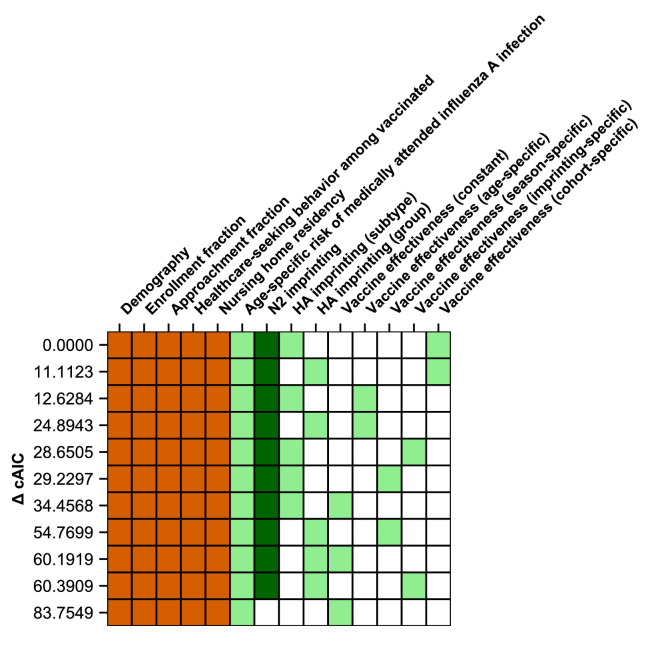
Ranking of models fitted to people ≥15 years old.A model including age-specific risk of medically attended influenza A infection, HA subtype imprinting, and birth-cohort-specific VE best fits cases of people ≥15 years old. The 11 main models are shown as rows with colored squares indicating whether that model uses parameters indicated by the columns. Orange squares indicate covariates that were not estimated. Light green squares mean that a given estimated parameter was supported. Dark green squares mean that the model did not support the inclusion of the parameters indicated by the column (i.e, the CI includes 0). Models are sorted by their cAIC relative to the best-fitting model.